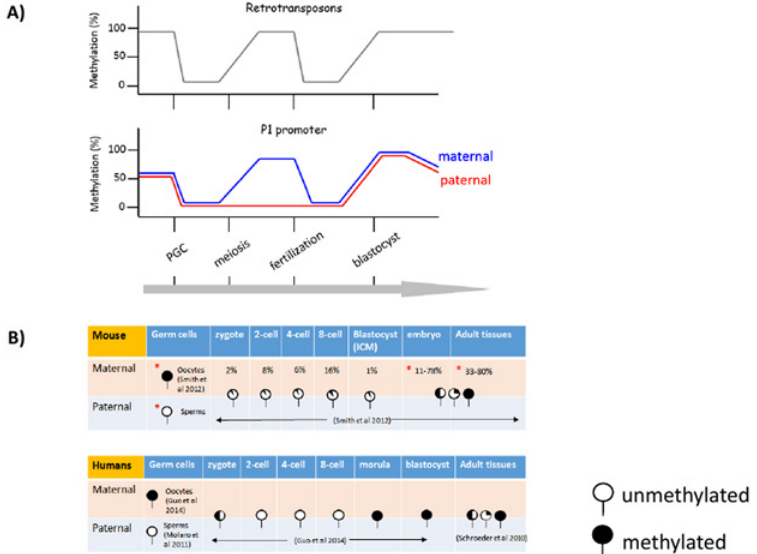
Fig 5. Summary of DNA methylation patterns of the P1 promoter during development. ( upper ) Retrotransposons as part of the mammalian genomes go through two rounds of DNA methylation setting as indicated by the fluctuating methylation levels (Y axis) during development (X axis). ( lower ) The retrotransposon-derived P1 promoter also goes through two rounds of the resetting process, but with two major modifications. First, the paternal allele (red line) does not regain DNA methylation during spermatogenesis. Second, the P1 promoter starts losing its DNA methylation levels at different rates between individual tissues after the implantation, resulting in varying levels of DNA methylation among adult organs (A). A table summarizing the overall changes of DNA methylation in Aebp2 P1 promoter in mouse [27] and human [17], [28], [29] during development (B). Developmental stages examined by COBRA analysis and bisulfite sequencing in this study are marked with red